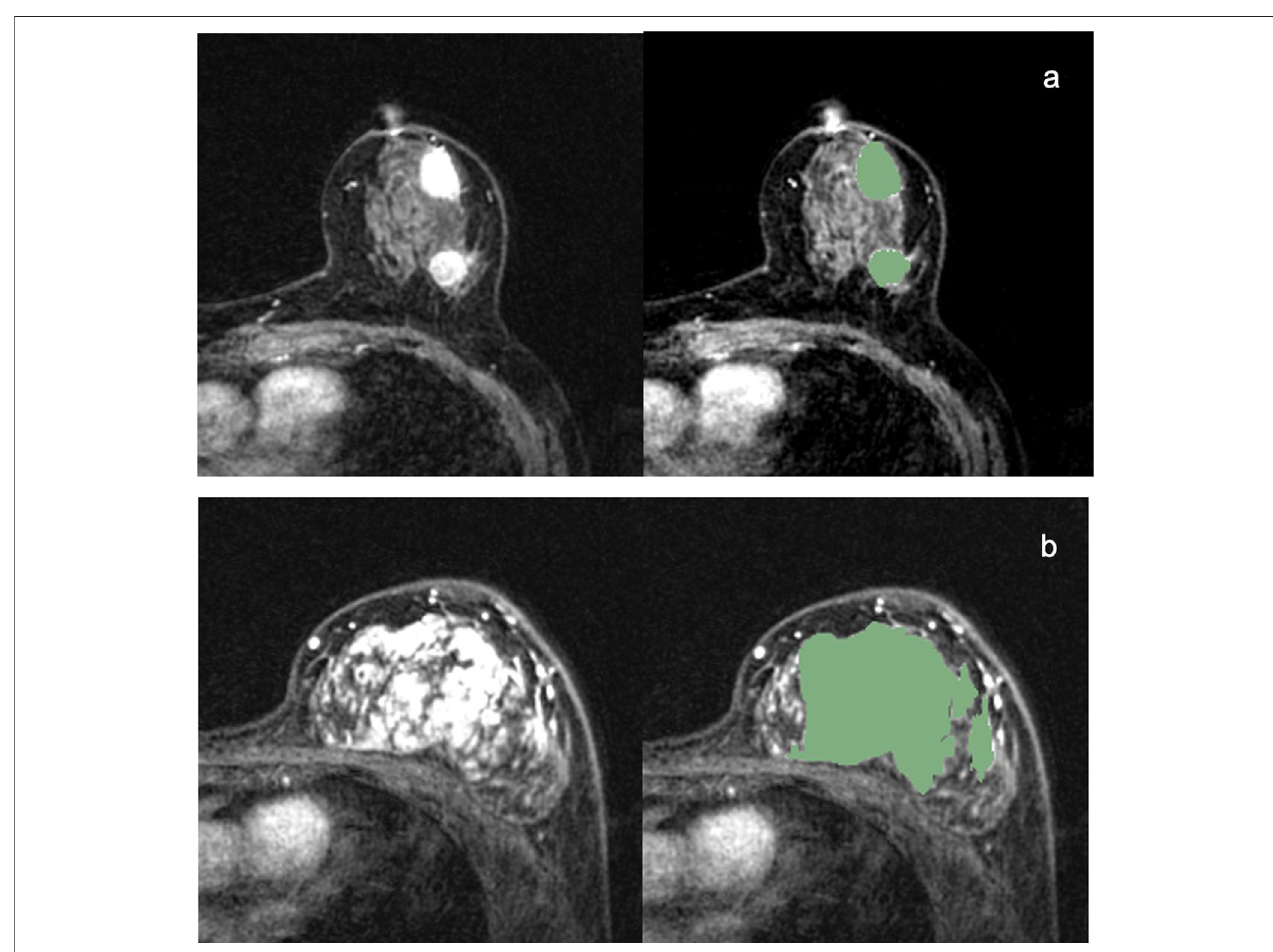
FIGURE 1 | Examples of 3D segmentations of Triple-negative breast